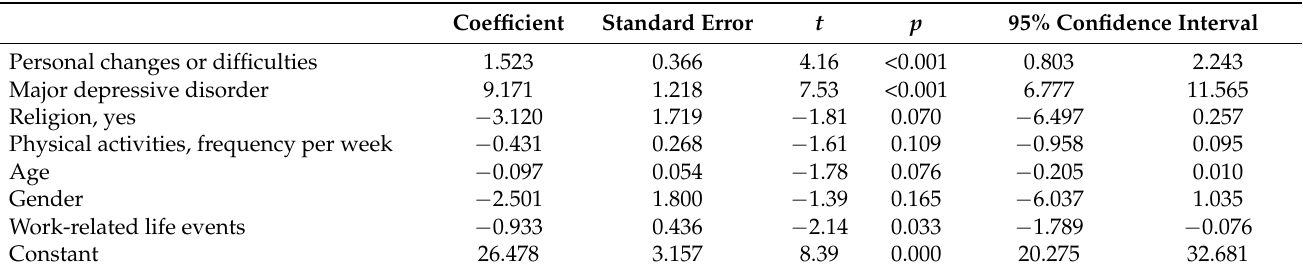
Table 3. Influence of life events of personal changes or difficulties on emotional exhaustion: Multiple linear regression analysis adjusted for confounders.